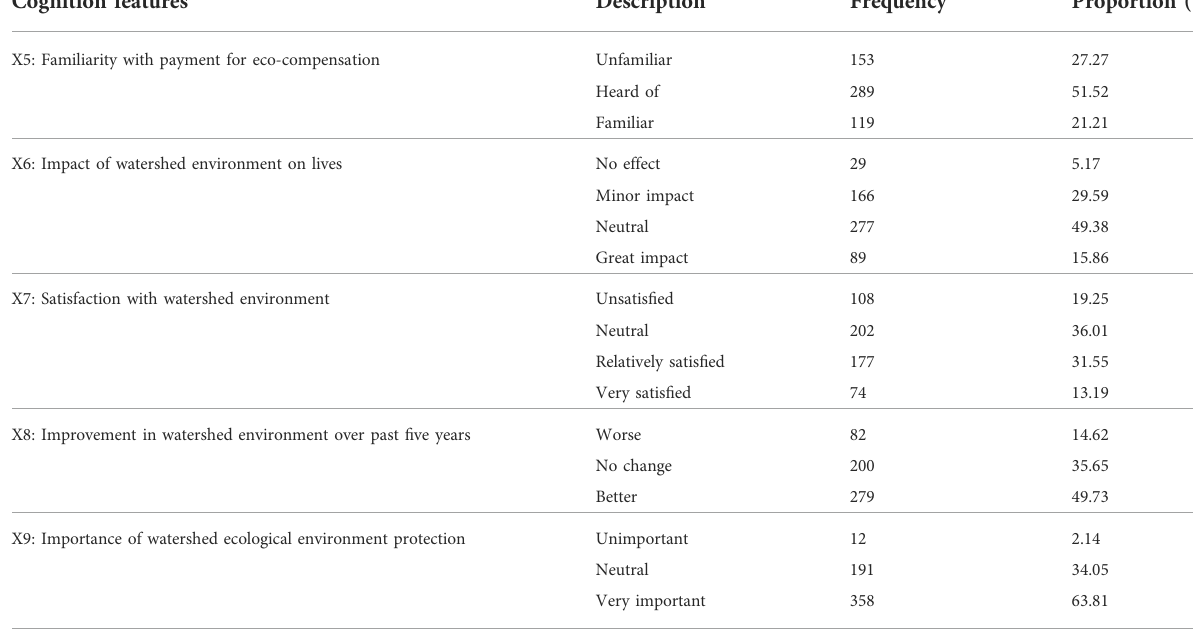
TABLE 2 Respondents ’ ecological cognition.